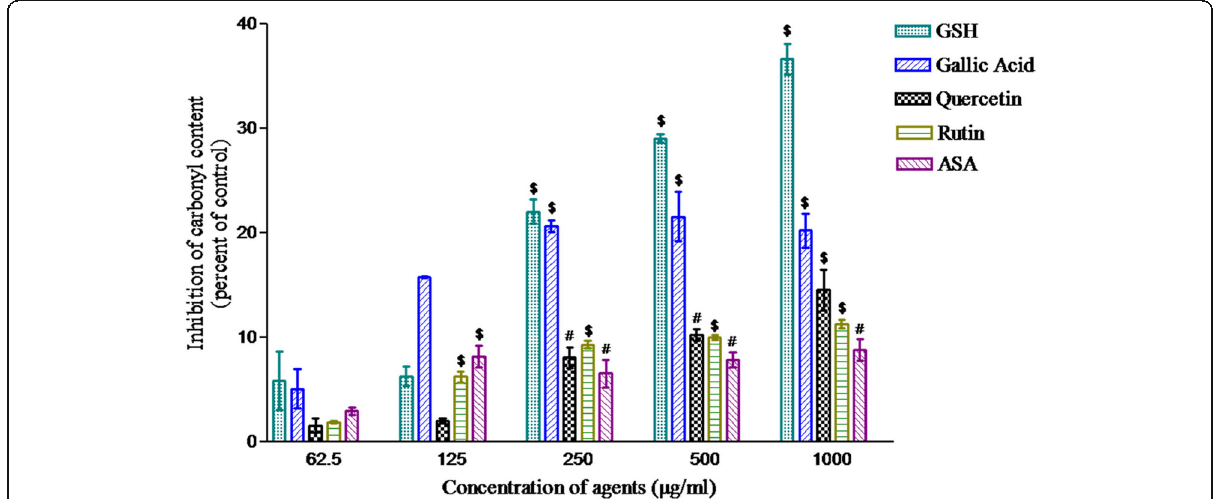
Fig. 3 Protein carbonyl content; inhibition in formation of protein carbonyls (nmole carbonyl/mg of protein) against Fenton reagent. Reduced glutathione, gallic acid, quercetin, rutin, vanillin and acetylsalicylic acid were added at 62.5 – 1000 μ g/ml. The test tubes were incubated for four hours at 37 °C followed by two consecutive centrifugations. The supernatant was used for protein carbonyl assay. Reduced glutathione was used as a positive control. Values are represented as mean±SEM of three samples. # ( p <0.01) and § ( p <0.001) represent significant changes relative to